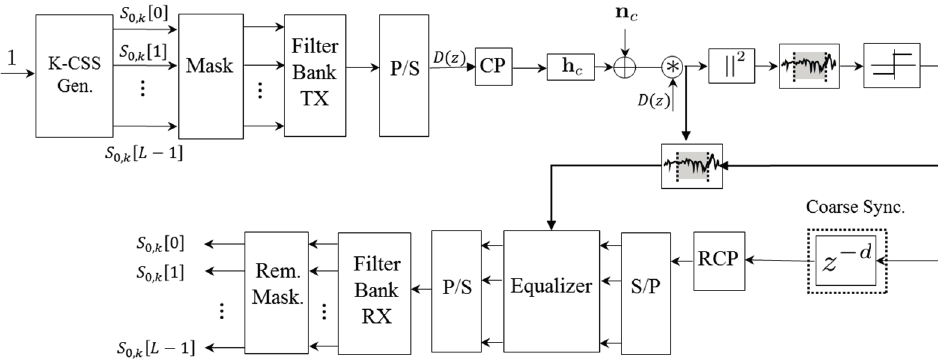
Figure 2. General block diagram of the signal processing modules involved in the PLC